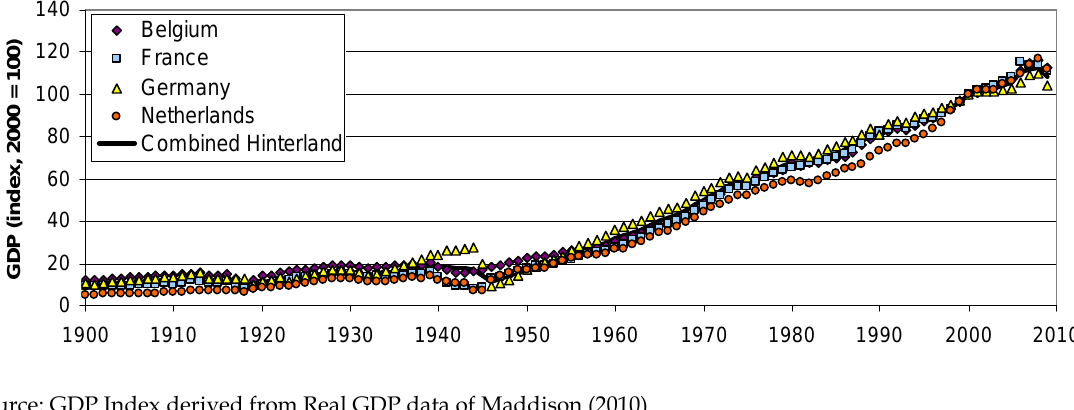
Figure 1. Historic development of GDP in the Hinterland of the Le Havre – Hamburg range Figure 1 shows that the GDP of the selected Hinterland areas follows a similar trend. Growth has generally been quite stable though a trend breach can be observed at the instance of the Second World War.